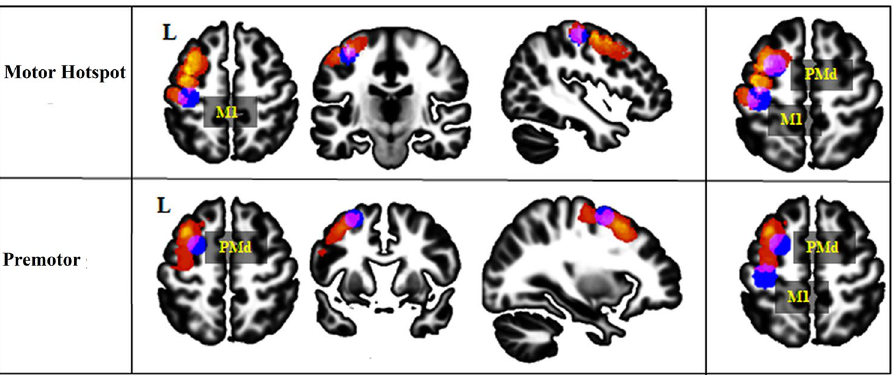
Figure 4. Location of the stimulation site. This figure displays the anatomical stimulation location sites in all the participants and shows an overlap of these sites with the standard left M1 or left PMd location for both groups. The anatomical stimulation sites are presented in a heat map, with individual subjects plotted in red and overlap between participants reflected in warmer colors (with yellow representing the surface shared by most of the participants). The standard M1 and PMd ROIs are displayed in blue. The overlap between the anatomical stimulation site location and the standard ROIs location is colored in purple. M1: primary motor area, PMd: dorsal premotor cortex, L: left